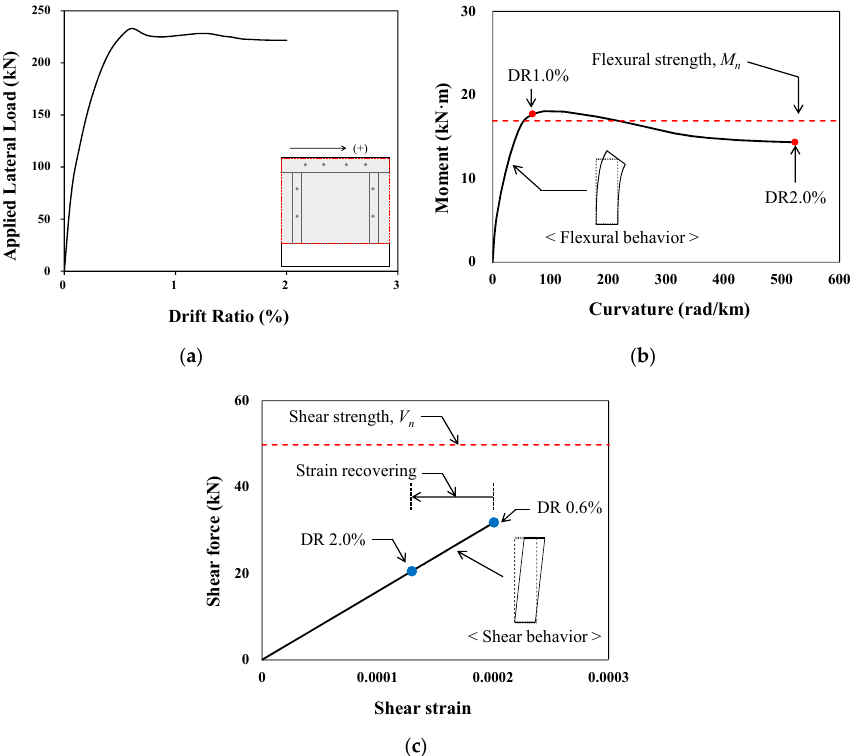
Figure 17. Flexural and shear behavior of column element in Specimen FBC: ( a ) pushover; ( b ) flexural behavior; ( c ) shear behavior.